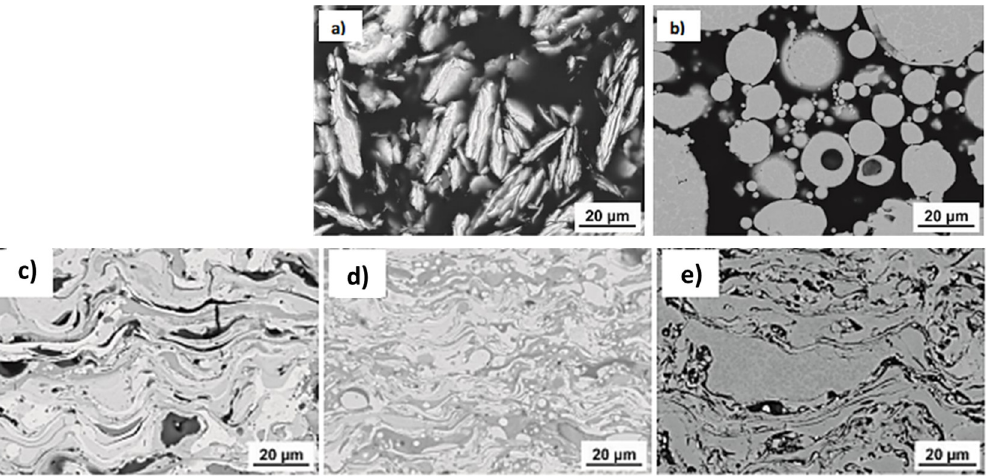
Figure 3. Backscattered scanning electron microscope images of ( a ) mechanically alloyed and ( b ) gas-atomized feedstocks of AlCoCrFeNiTi powders. Coating microstructure of the AlCoCrFeNiTi HEA coatings for ( c ) mechanically blended, ( d ) mechanically alloyed, and ( e ) gas atomized feedstock powders. The different microstructural features with respect to different feedstock powders are clearly visible in the figure, with the gas-atomized powder coatings showing homogeneity compared to the other two coatings [14]. Table 1. The list of suppliers that provide high-entropy alloy feedstocks.